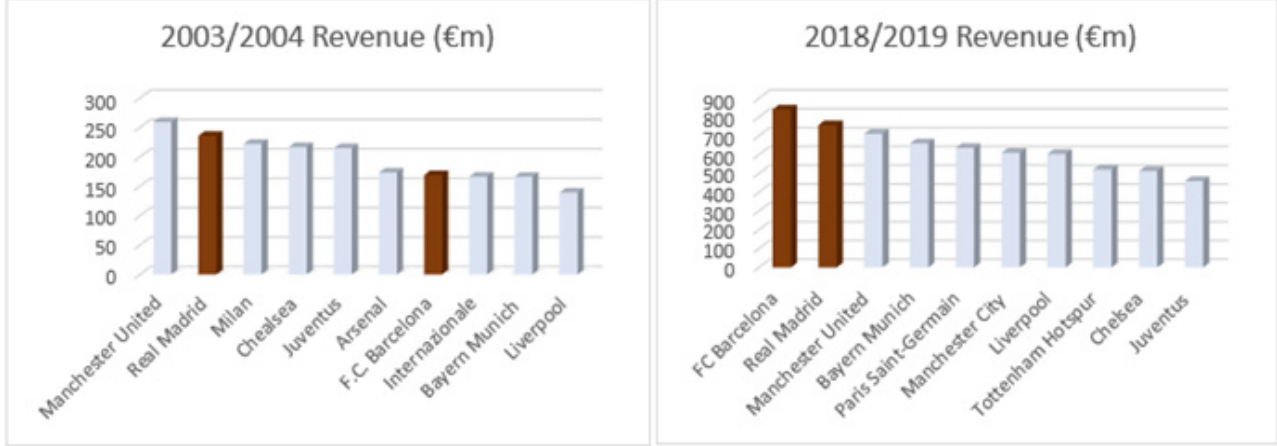
Figure 1. Evolution of the top 10 clubs in terms of revenue.